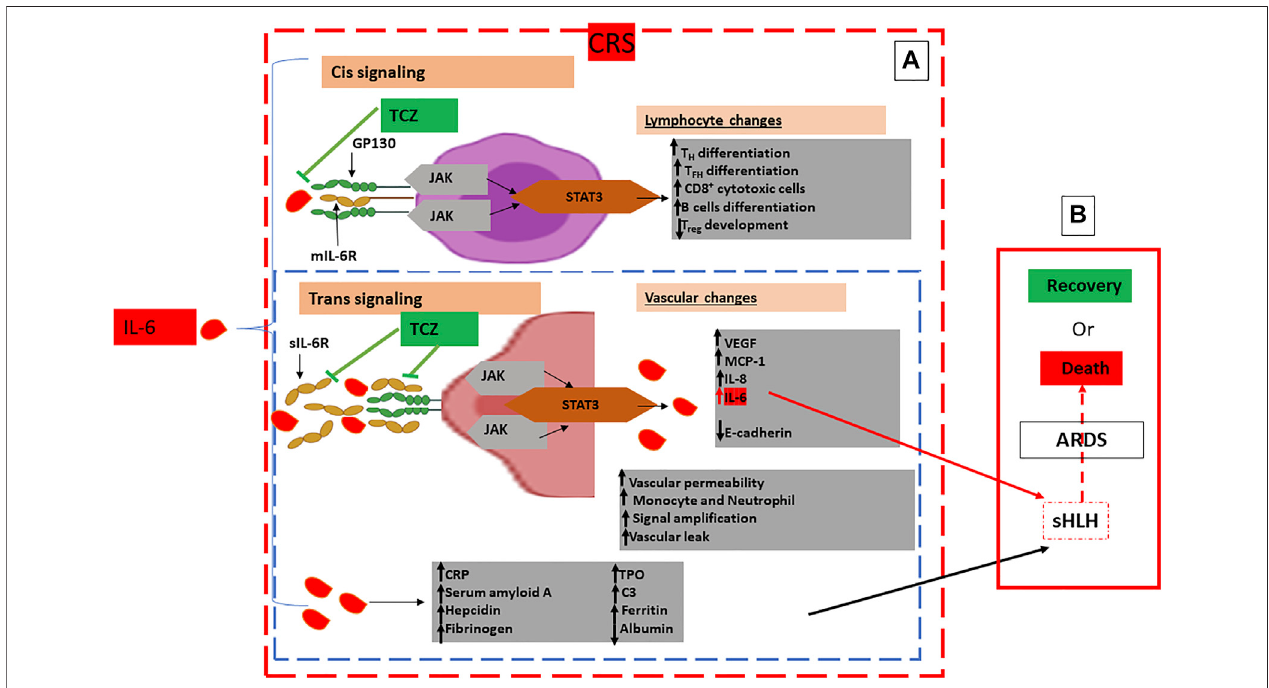
FIGURE 3 | Schematic Representation of Pathogenic Host Response to SARS-CoV-2 and Pathways to Cytokine Release Syndrome (CRS): (A) : Hyperin fl ammatory phase: CRS characterised by excessive concentrations of IL-6 leading to an ampli fi ed IL-6 – sIL-6R – JAK-STAT3 Cis and Trans signaling pathways with, respectively, lymphocyte and vascular changes in multiple cell types such as lymphocytes and endothelial cells characterised by excessive in fi ltration of immune cells in the lungs, systemic overproduction of pro-in fl ammatory cytokines and aberrant regulation. (B) : Multiorgan dysfunction: Characterised by extrapulmonary organsinvolvement,sHLH,ARDSandultimatelytoCOVID-19patients ’ death.ImmunomodulatorytreatmentbyIL-6antagonistsisrepresentedbyTCZdirectedagainst boththesolubleandthemembrane-boundformsofIL-6RtoinhibitbothCISandTranssinglingpathways: Glycoprotein130:gp130;mIL-6R :membrane-boundIL-6 receptor; sIL-6R :solubleIL-6receptor; JAK :Januskinase; MCP-1 :MonocyteChemoattractantProtein – 1; STAT3 :SignalTransducerandActivatorofTranscription3; T FH : T follicular helper cell; T H17 : T helper 17 cell; TPO : Thrombopoietin; T reg : T regulatory cell; VEGF : Vascular Endothelial Growth Factor; C3 : Complement 3; CRP : C Reactive Protein; TCZ : Tocilizumab; : Endothelial cell; :